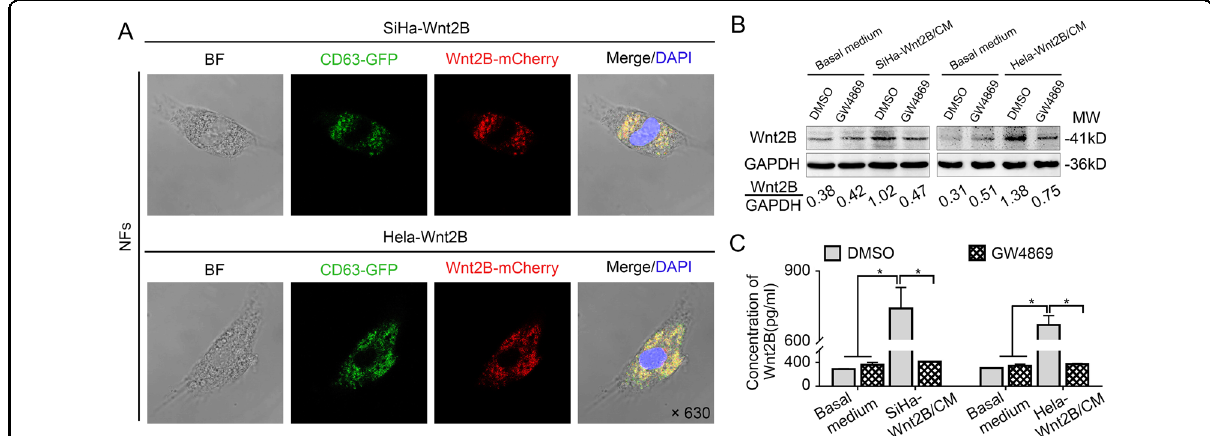
Fig. 3 Wnt2B can be transferred to fi broblasts via exosome secretion. A Fibroblasts co-cultured with SiHa-Wnt2B and Hela-Wnt2B cells for 48 h imaged using confocal microscopy at ×630 magni fi cation with morphology (bright fi eld, BF), Wnt2B-mCherry (red), CD63-GFP (green), and DAPI (blue). B Western blot analysis for Wnt2B in fi broblasts cultured in the CM of SiHa-Wnt2B and Hela-Wnt2B cells after DMSO or GW4869 (15 μ M) treatment for 2 days. GAPDH was used as the loading control. C ELISA analysis for Wnt2B in treated fi broblasts. Error bars represent the mean ± SD of three independent experiments. * P <